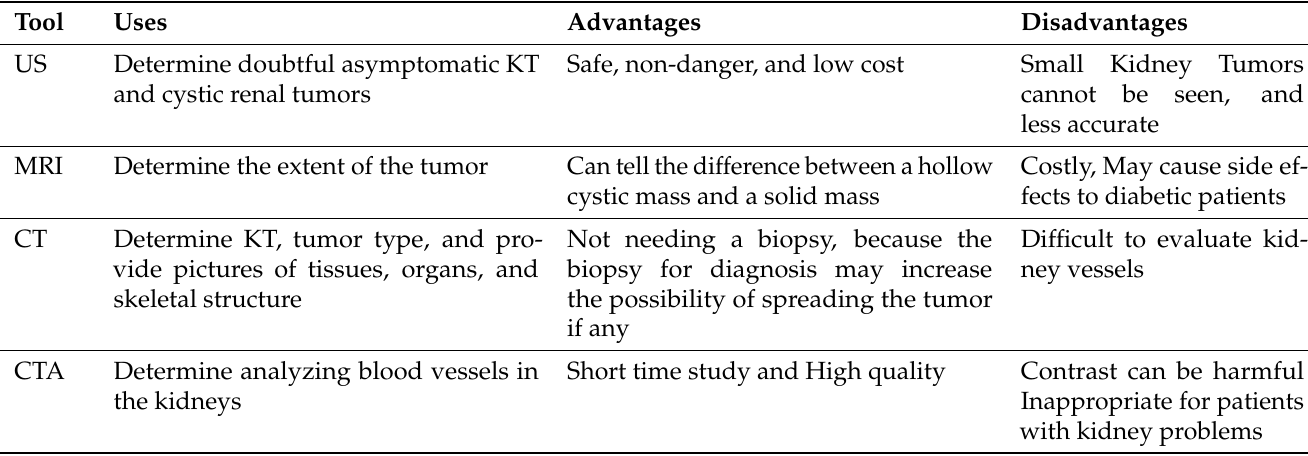
Table 1. Overview of uses, advantages, and disadvantages of radiological